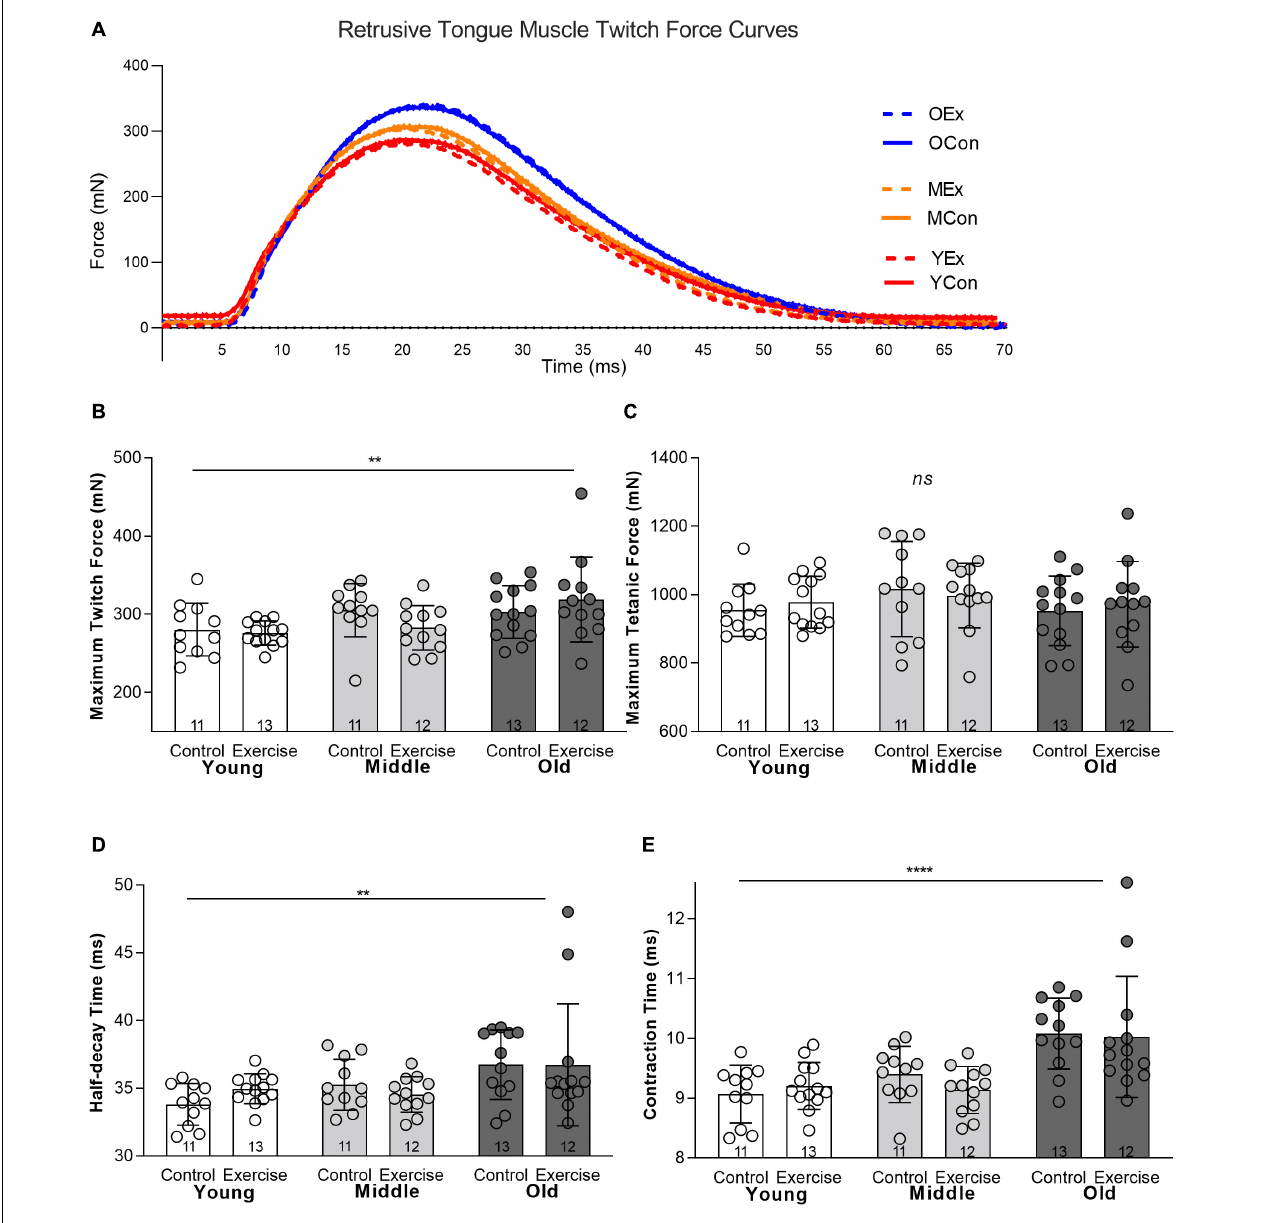
FIGURE 2 | In vivo retrusive tongue muscle contractile properties showed significant differences for age, but were not significantly impacted by exercise. (A) Example twitch force curves are shown for one individual rat from each of the six experimental groups. YEx = Young adult, Exercise, YCon = Young adult, Control, MEx = Middle aged, Exercise, MCon = Middle aged, Control, OEx = Old age, Exercise, OCon = Old age, Control. (B) Maximum Twitch Force (C) Maximum Tetanic Force, (D) Half-decay Time, (E) Contraction Time. Bars show mean and SD, with specific group sample sizes indicated. Each symbol indicates data for one rat. **** = P < 0.0001, ** = P < 0.01, ns = no significant